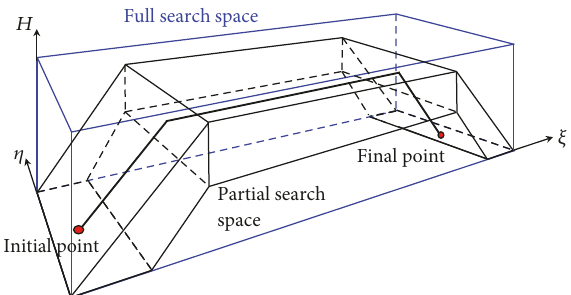
Figure 4: Search space for dynamic programming ( 𝑉 axis is not